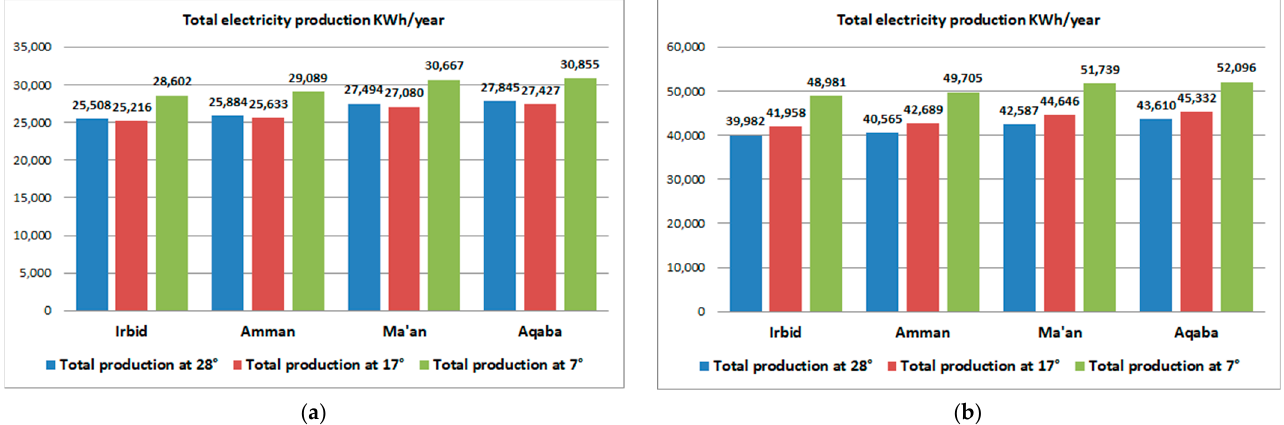
Figure 5. Total electricity production from the installation of PV systems on the rooftops of ( a ) single houses and ( b ) villas. houses and ( b )